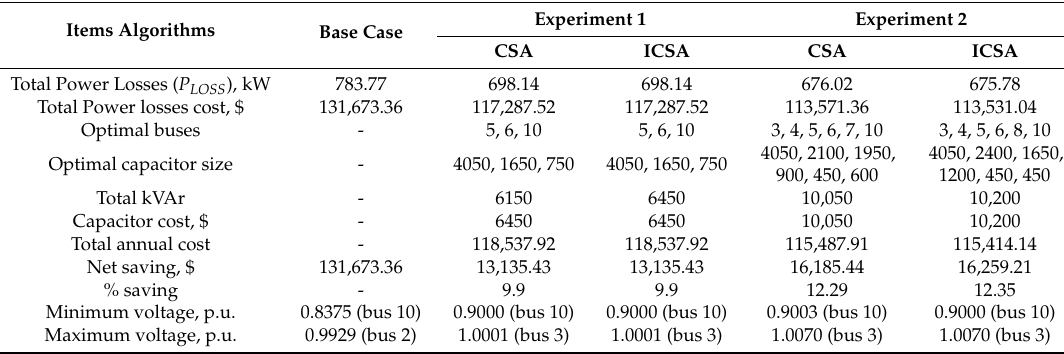
Table 10. Experiments results of ICSA over CSA in 10-bus system.